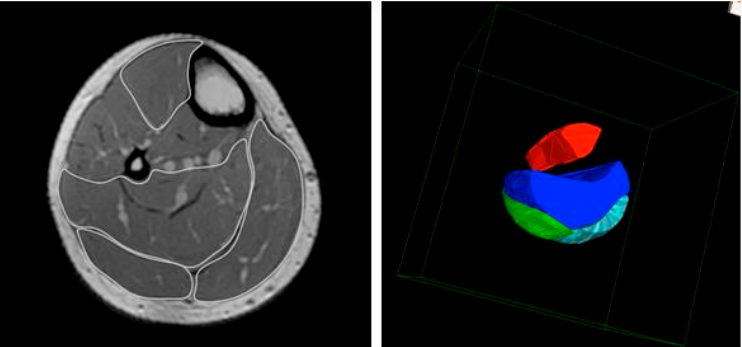
Figure 2. ( Left ) Boundaries of the GM, GL, SOL and TA muscles, which were delimited in the DP images. ( Right ) Muscles’ volumes computed with the ACSA determined in each slice of each